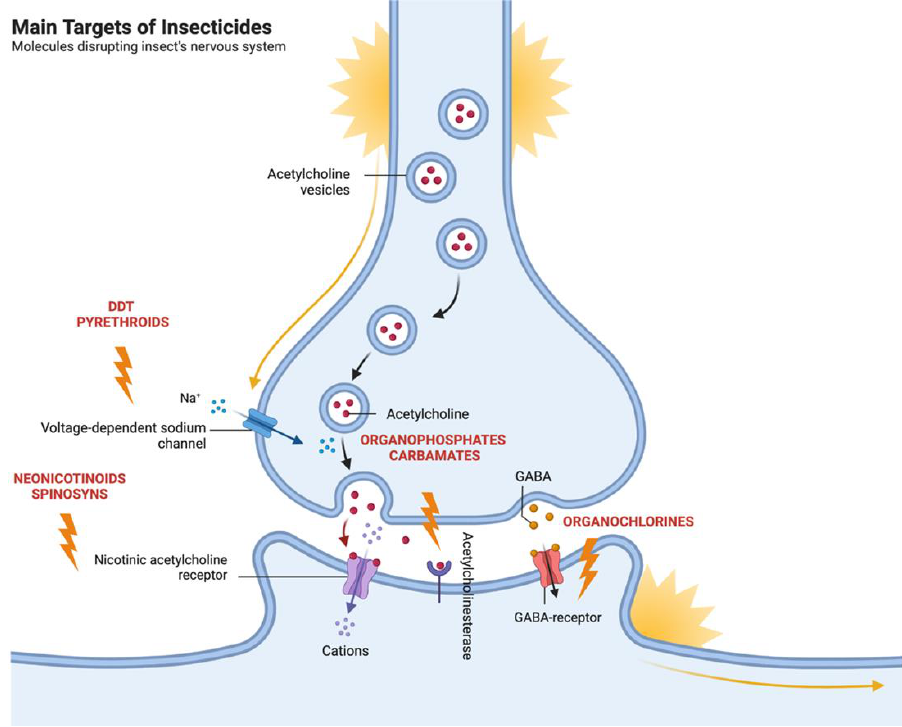
Figure 1. Schematic representation of the main targets and classes of insecticides that disrupt the insect nervous system. The diagram illustrates the common molecular targets, including ( a ) voltage- dependent sodium channels, ( b ) acetylcholinesterase, ( c ) GABA receptors, and ( d ) nicotinic acetyl- choline receptors. The main classes of insecticides that act on these targets are also represented and include pyrethroids, DDT, organophosphates, carbamates, organochlorines, and neonicotinoids. These insecticides cause paralysis and the death of the insect by disrupting its nervous system.